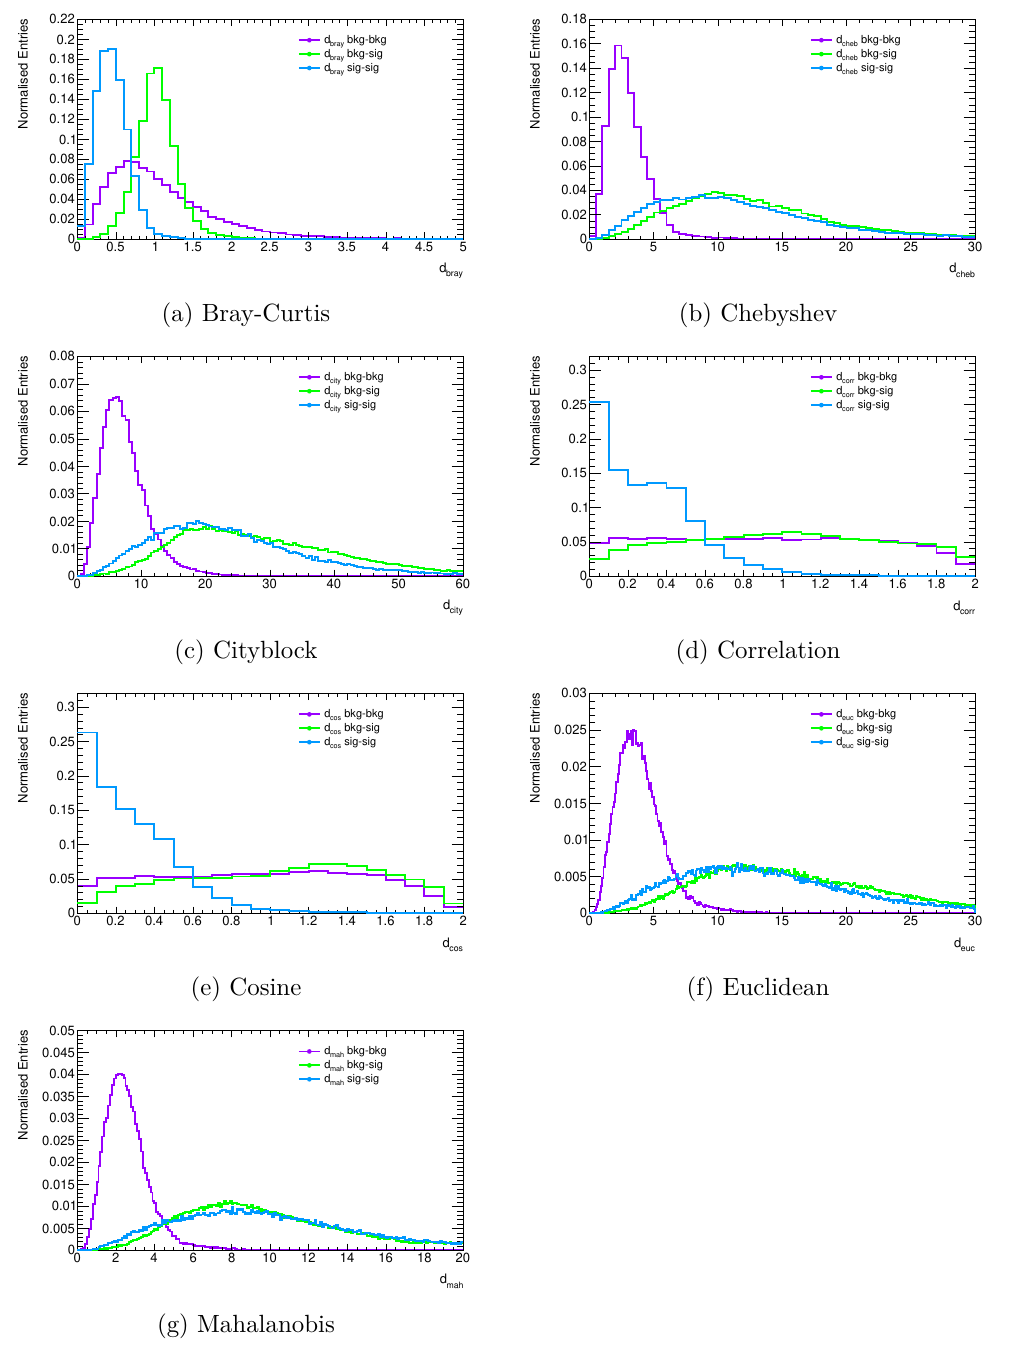
Figure 2. Distributions of the distance metrics used in our prototype electroweakino